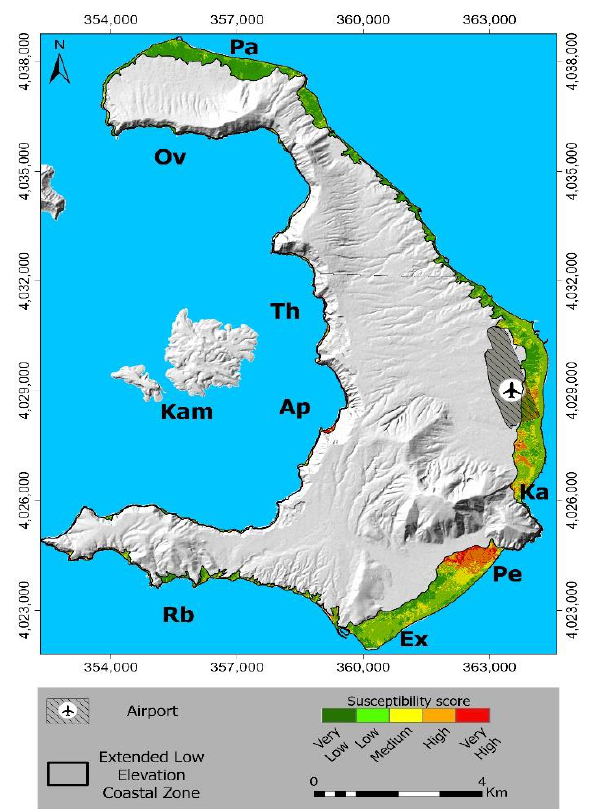
Figure 13. AHP ranking of Thira island ’ s extended low elevation coastal zone multi-hazard susceptibility map.